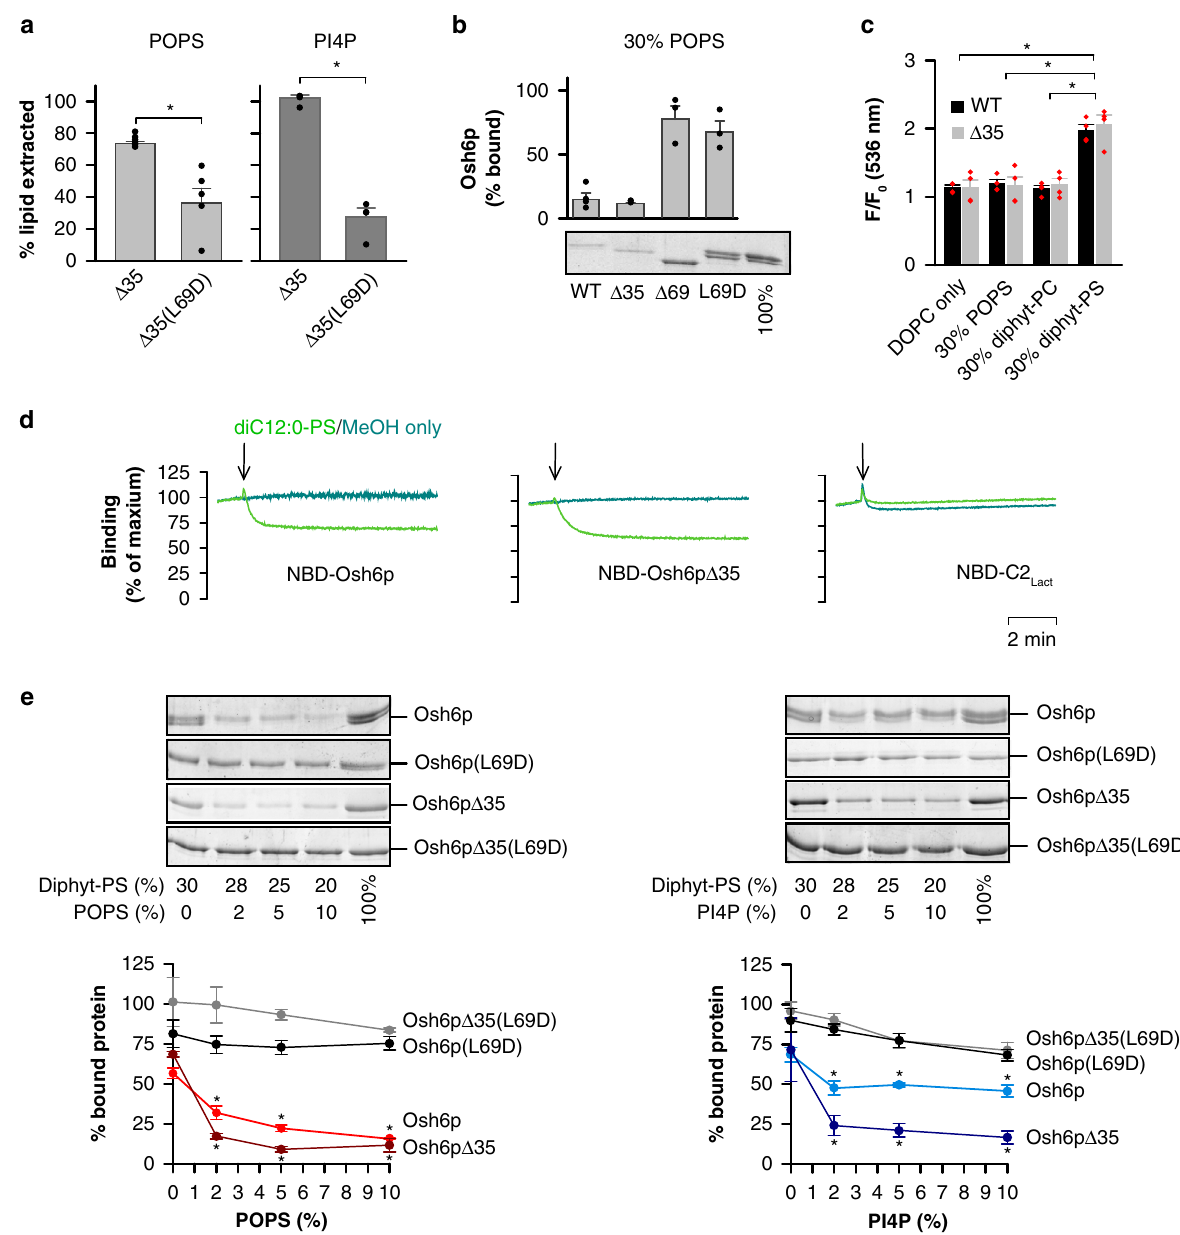
Fig. 4 Osh6p dissociates from anionic membranes when it extracts a lipid ligand. a PS and PI4P extraction assay. Percentage of accessible PS or